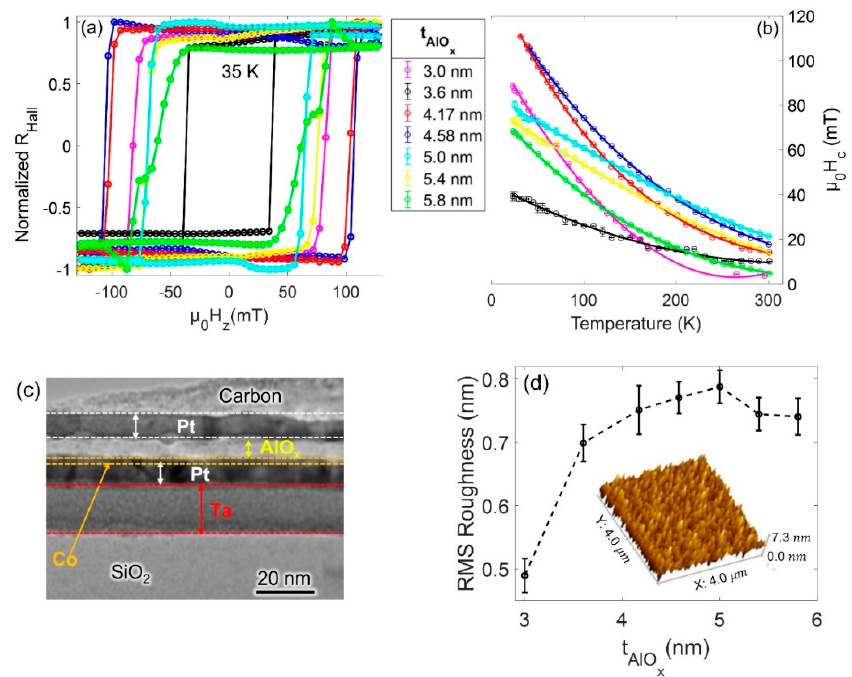
Figure 3. ( a ) Normalized anomalous Hall resistances versus the OOP field H z for different t AlO measured at 35 K temperature. ( b ) Temperature dependence of the coercive fields for the sample of varying aluminum oxide thicknesses. ( c ) Transmission electron microscopy image displaying the layered structure of the Pt (4 nm)/Co (1.1 nm)/AlO x (4.8 nm) sample. ( d ) Plot showing the roughness of all PMA samples as a function of aluminum oxide thickness. The inset in ( d ) represents the 4 × 4 μ m 2 atomic force microscopy image of Pt (4 nm)/Co (1.1 nm)/AlO x (4.8 nm).